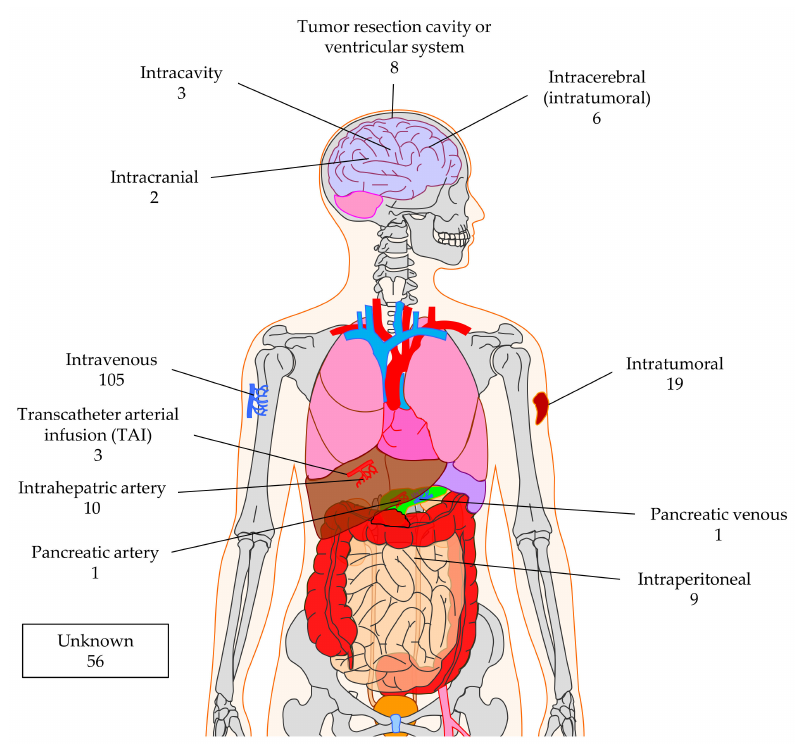
Figure 9. Schematic overview of the injection sites used to apply CAR-T cells against solid tumors. The numbers indicate the number of clinical trials using this injection site. Data was extracted from clinicaltrials.gov. The Motifolio Scientific Illustration Toolkit was used for the generation of this figure.